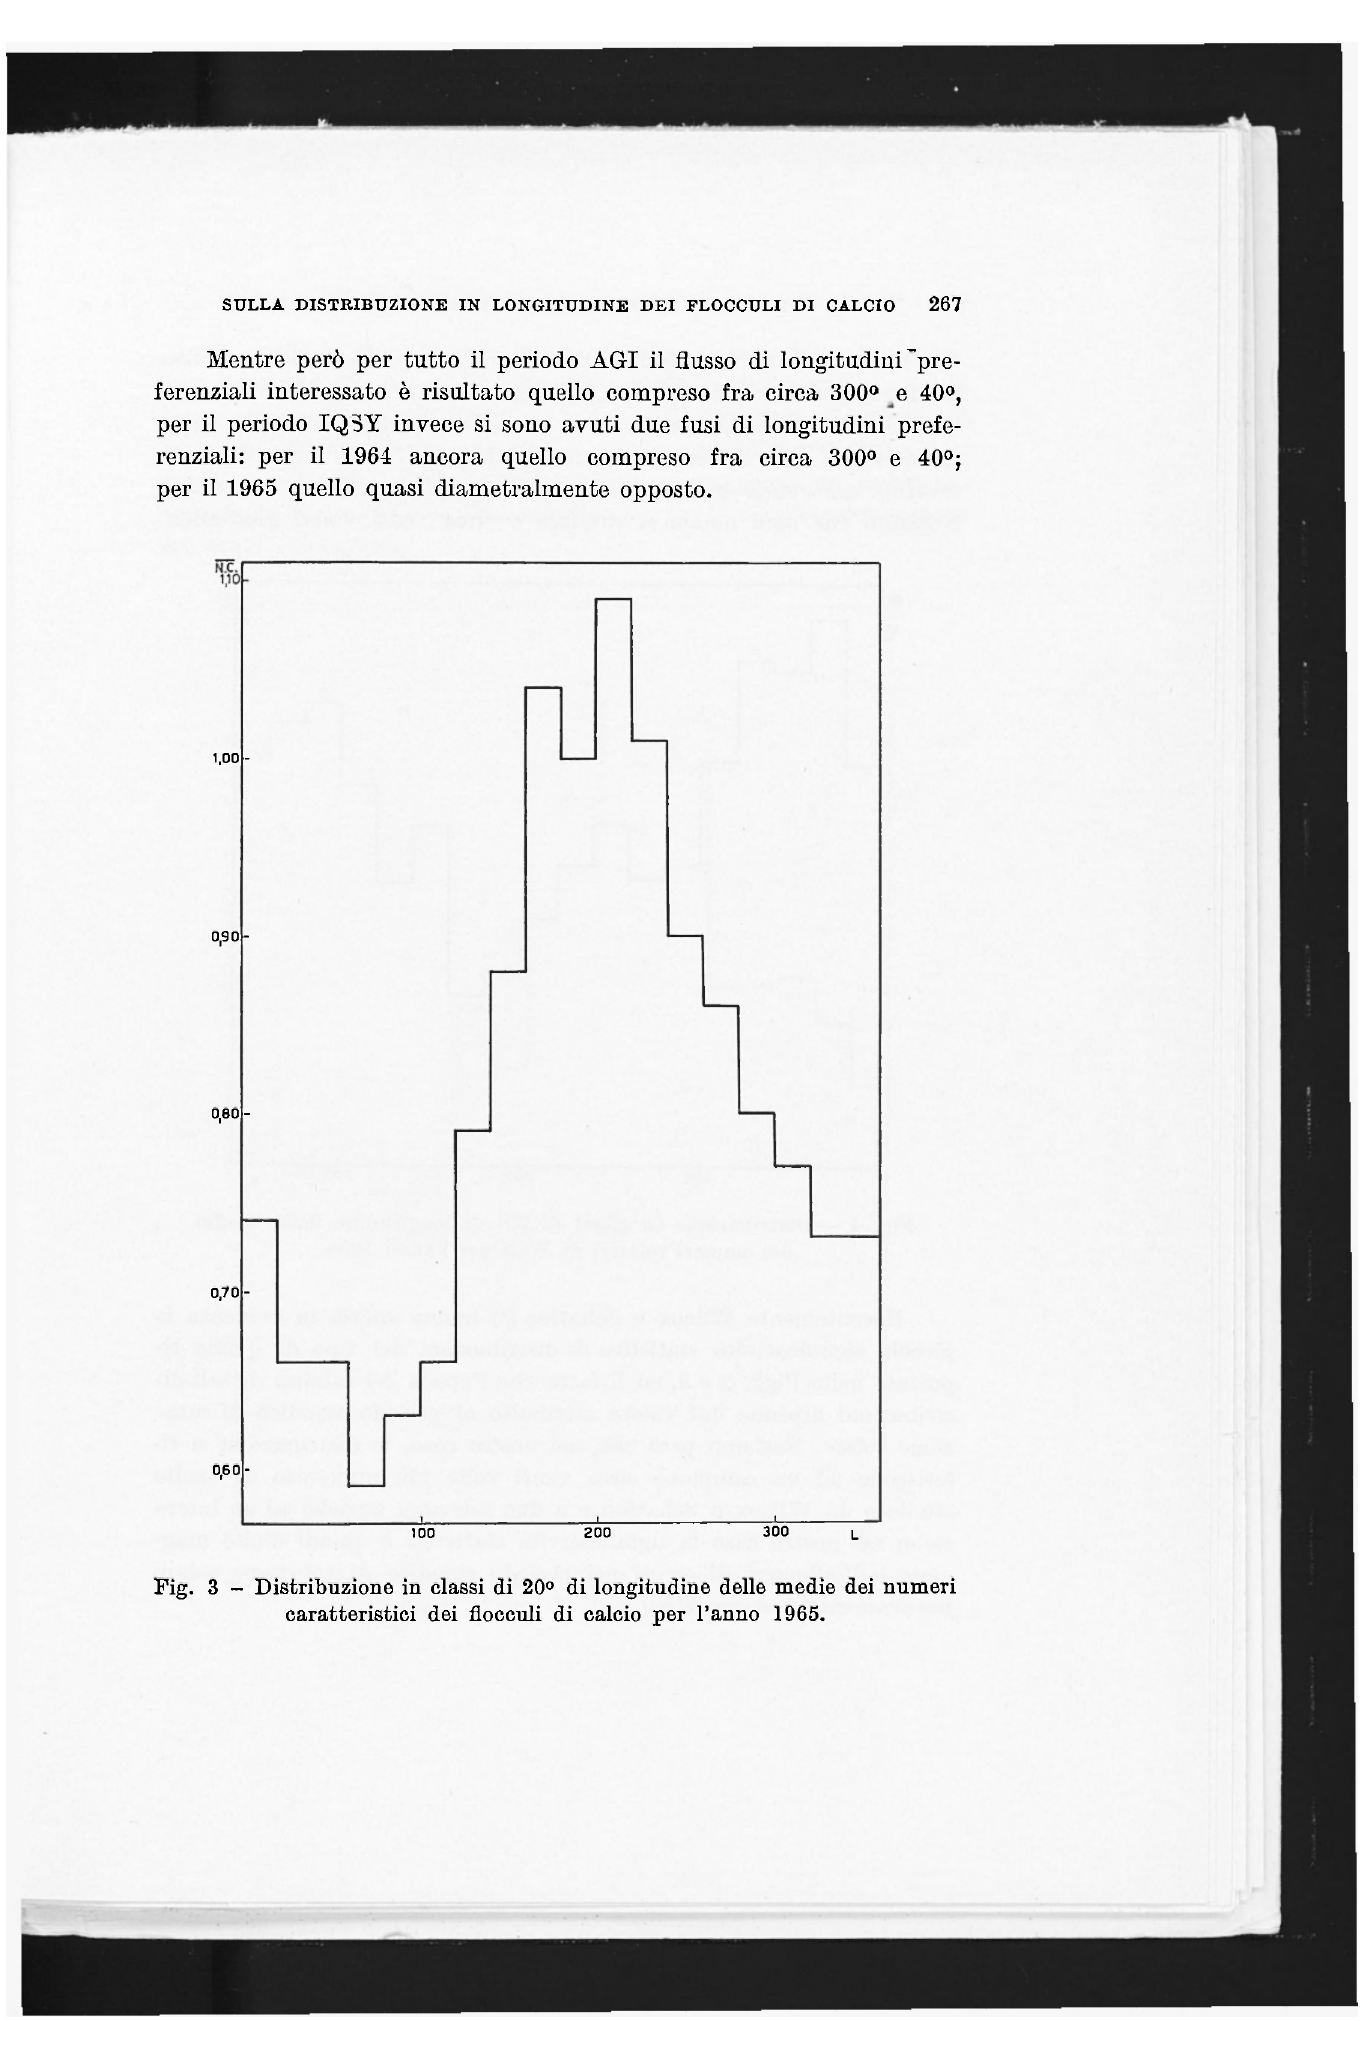
Fig. 3 - Distribuzione in classi di 20° di longitudine delle medie dei numeri caratteristici dei flocculi di calcio per l'anno